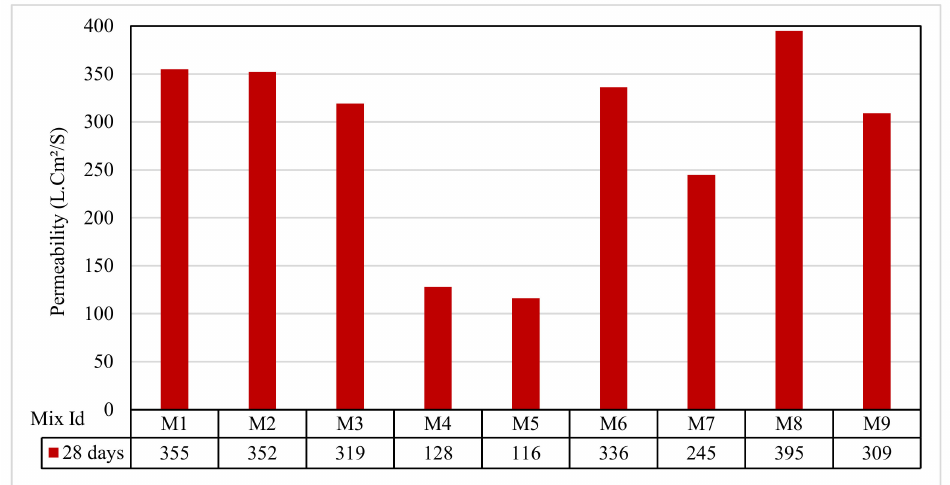
Figure 11. The permeability test